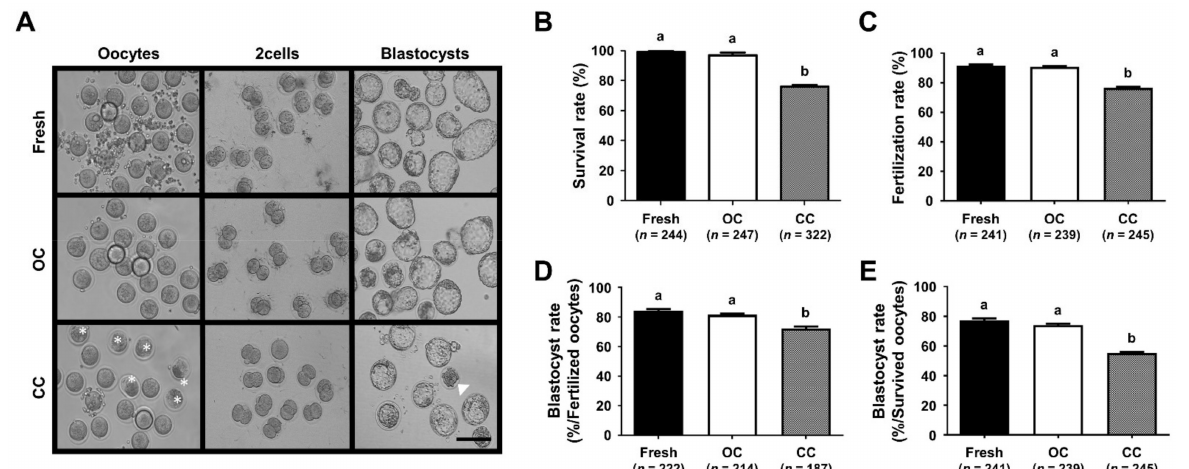
Figure 2. Comparative analyses of reproductive outcomes of vitrified/warmed (VW) oocytes using two different carrier systems. ( A ) Representative microscopic images of pre-implantation embryos in vitro fertilized and developed from VW oocytes using different carrier systems. White asterisks and an arrowhead indicate lysed oocytes and arrested embryo, respectively. Scale bar = 140 µ m. ( B – E ) Comparison of the survival ( B ), fertilization ( C ), and blastocyst formation rates ( D , E ) of VW oocytes with different carrier systems. Blastocyst formation rates (the number of blastocysts/the number of fertilized oocytes ( D ) and/the number of survived oocytes ( E )). Different superscript letters (a, b) indicate p < 0.05. The number of experiments = 10 (24–33 oocytes per each group in each experiment). Fresh, fresh control; OC, open carrier system; CC, closed carrier